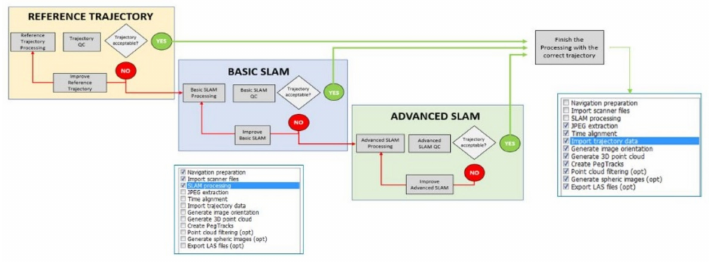
Figure 30. Fused SLAM Processing